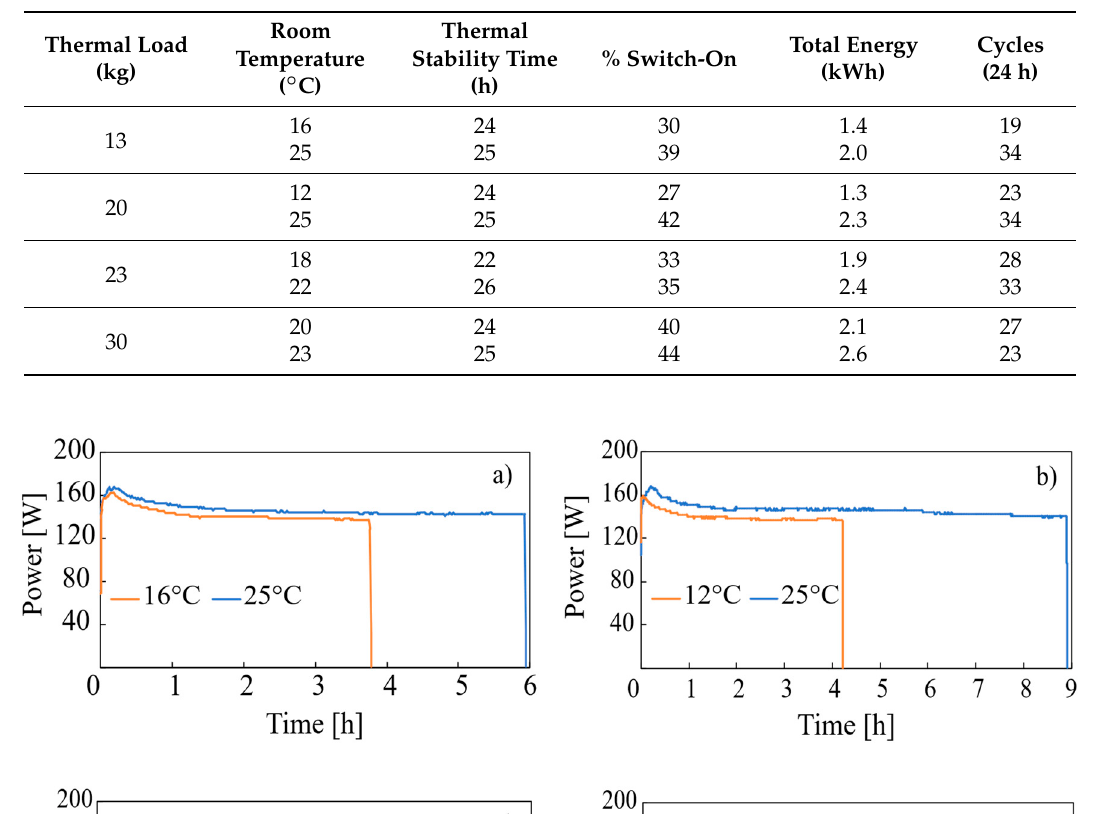
Table 4. Energy behavior for different thermal loads.